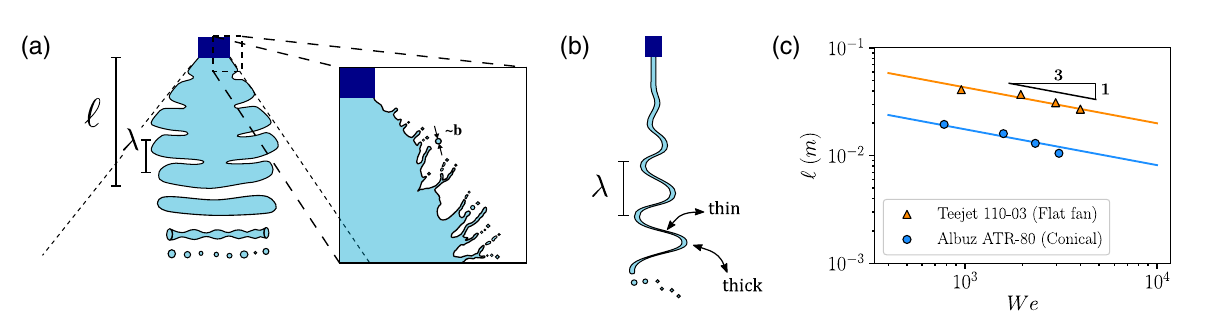
FIG. 5. Schematic representation of the breakup mechanism for the flat fan nozzle. The front view (a) shows how pieces of the sheet of the order of the Squire wavelength rupture from the main sheet to form ligaments at a distance of l . The ligaments are due to the Rayleigh-Taylor instability and break up into droplets. The side view (b) displays the thickness modulations caused by the increase in amplitude of the Squire wave that eventually lead to the breakup of the sheet. In panel (c), we plot the breakup distance l as a function of the Weber number for the Teejet 110-03 (flat fan) and Albuz ATR-80 (cone) nozzle. Distances were obtained by analysis of high-quality pictures of the sprays for different pressures. The fit line shows a − 1 = 3 power